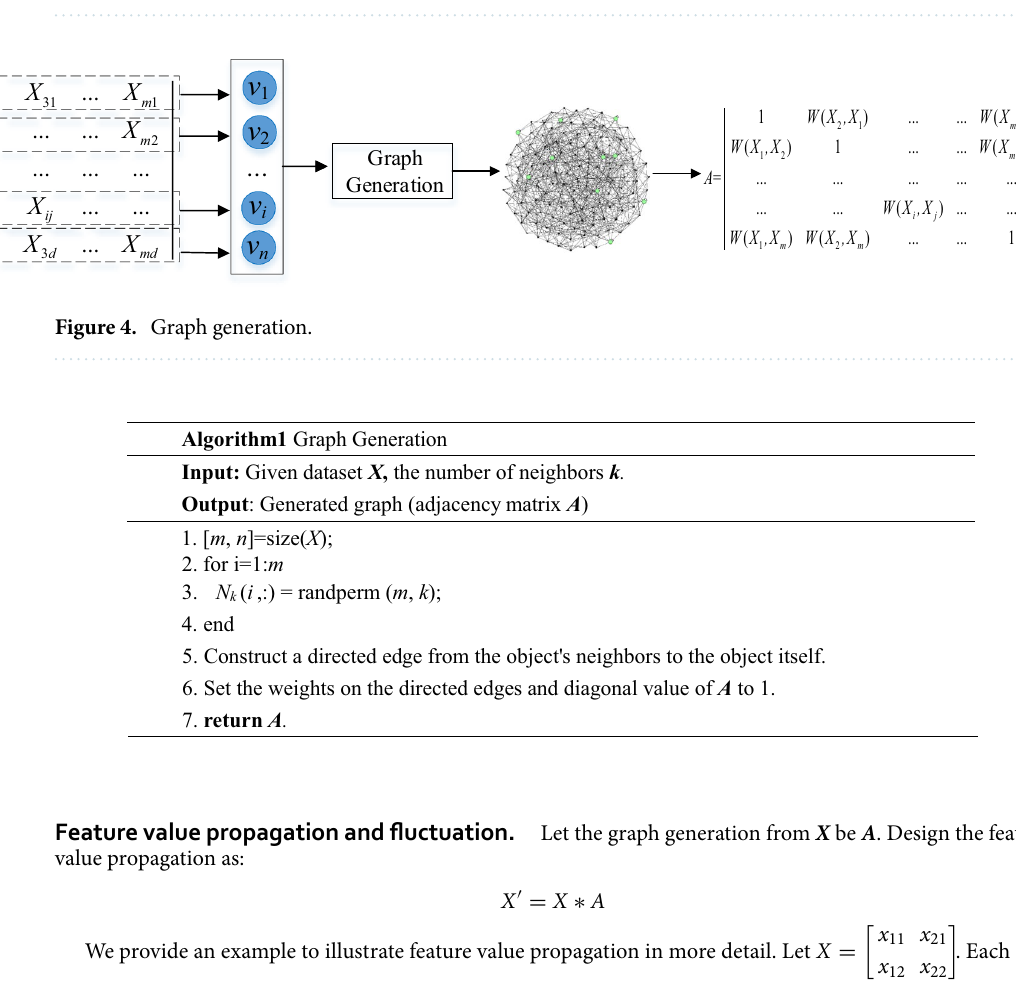
Figure 3. Using the real-world dataset wine to describe the ratio of outliers in N k ( x i ) is similar to the original ratio. ( a ) Includes 129 objects with 10 outliers, and the rate of outliers is 7.75%. ( b ) Shows that by randomly selecting k objects from ( a ) and constructing the neighborhood of x i , the average rate of outliers in N k ( x i ) are 8% (when k takes different values, the average value is taken of 10 executions).